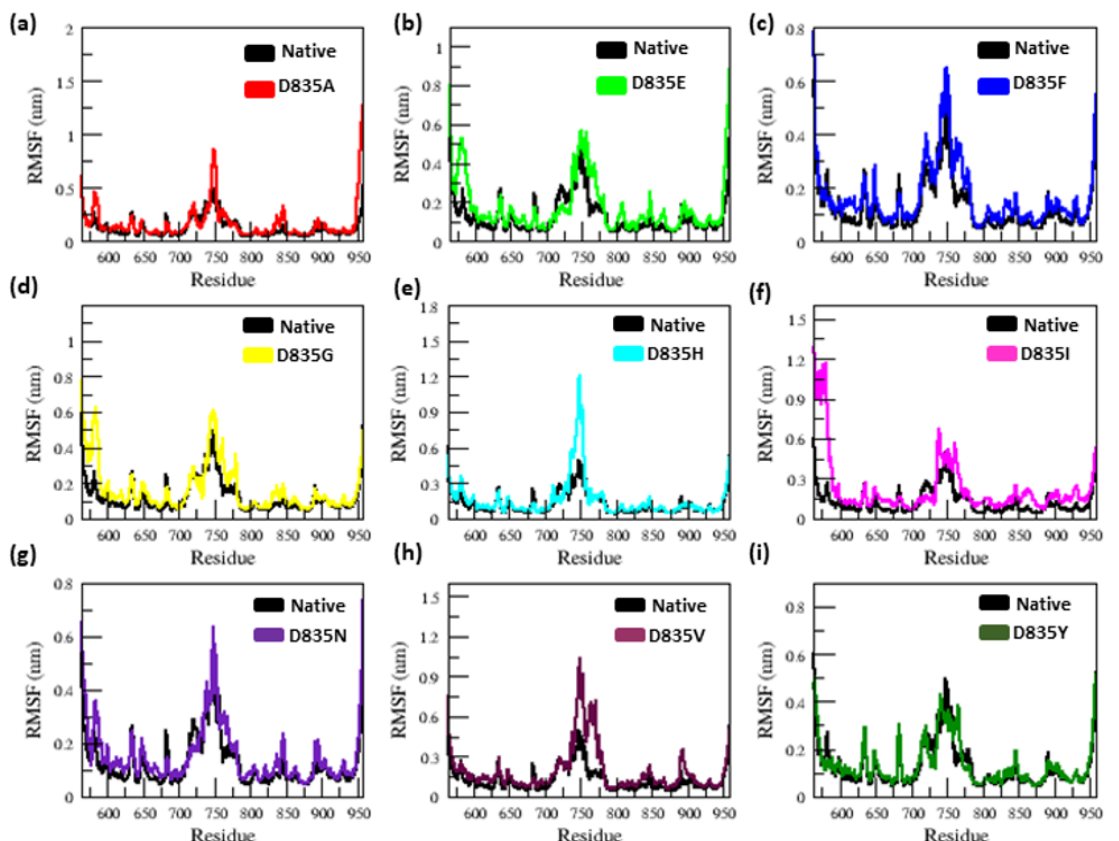
Figure 2. The C- α RMSF simulation data for native and mutant FLT3 protein structure’s residues during the time span of 200 ns. ( a ) Native vs. D835A; ( b ) Native vs. D835E; ( c ) Native vs. D835F; ( d ) Native vs. D835G; ( e ) Native vs. D835H; ( f ) Native vs. D835I; ( g ) Native vs. D835N; ( h ) Native vs. D835V; ( i ) Native vs. D835Y. Table 2. The percentage of secondary structural elements of native and mutants FLT3. Secondary Structures of Protein Protein Type Helix Beta-Sheets Coil Turn